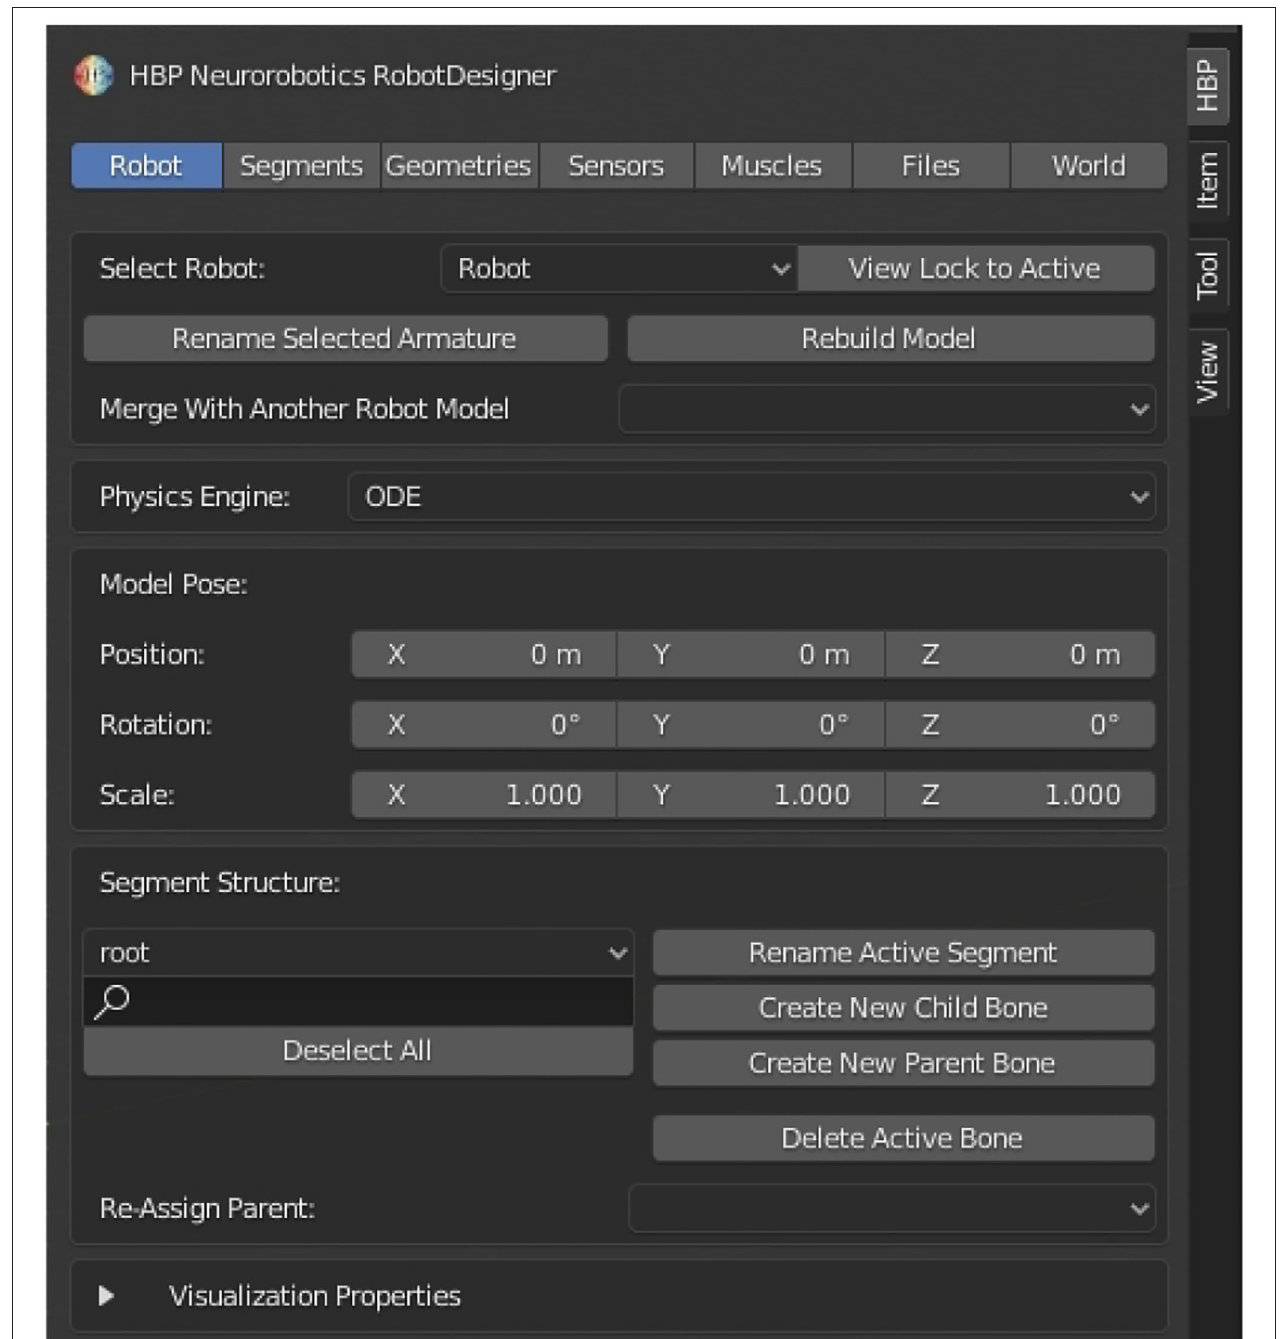
FIGURE 2 | Robot Designer Graphical User Interface: The user interface is subdivided into separate sections, which guide the user through the dedicated steps in the design process and can be selected via tabs on the top line. Sections include: Robot, Segments, Geometries, Sensors, Muscles, Files, World.